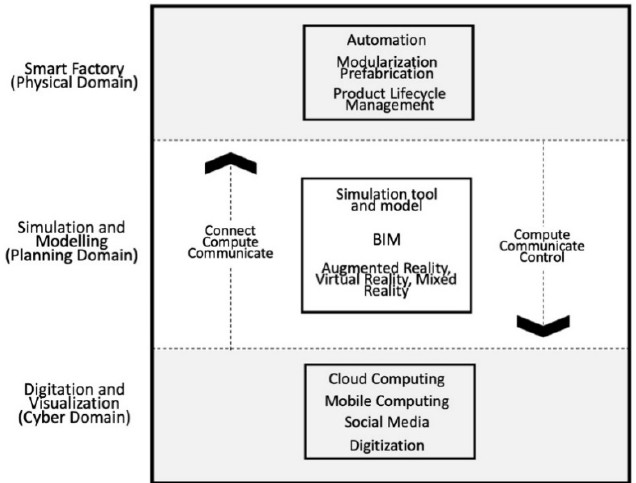
Figure 7. Concept of technologies in Industry 4.0 with BIM as its core structure with collaboration and an autonomous synchronization system.